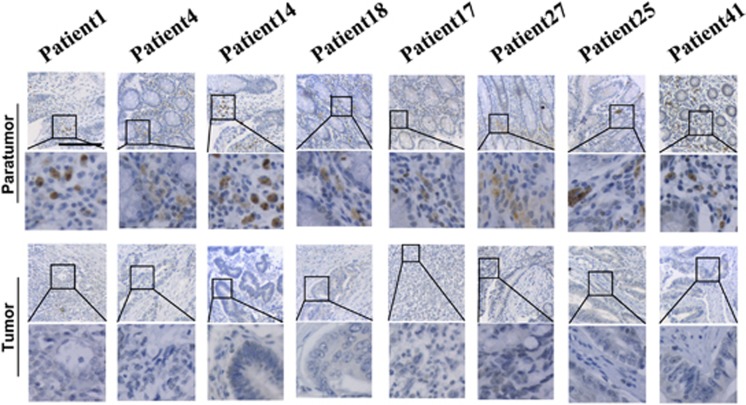
Tissue chip analysis of NALP1 expression in paratumoral tissue and tumor tissues. The cytoplasm of both glandular epithelial cells and interstitial cells stained positive for NALP1. Epithelial cells in normal colon tissues expressed more NALP1 than cancer tissues. Scale bars=50 μm. According to TNM staging, patients 1 and 4 are stage I, patients 14 and 18 are stage II, patients 17 and 27 are stage III and patients 25 and 41 are stage IV. We selected two typical representative examples for each stage